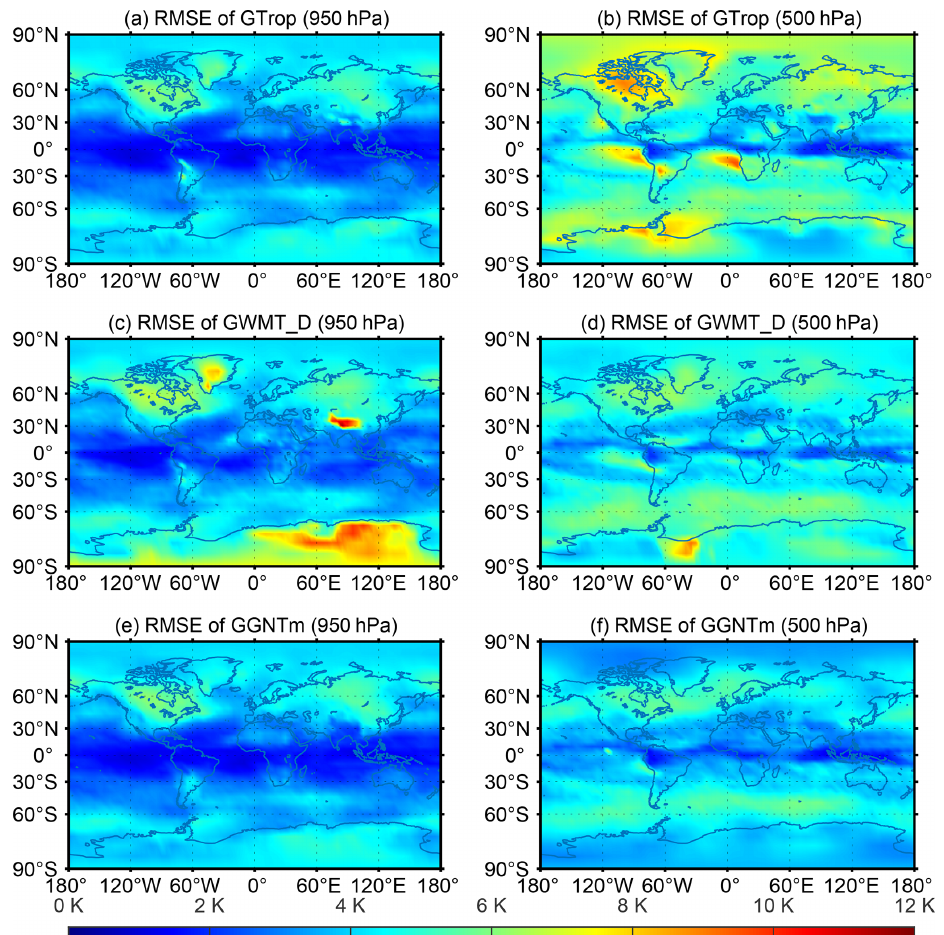
Figure 5. RMSE of T m at each grid point at 950hPa (a, c, e) and 500hPa (b, d, f) pressure levels in 2018 resulting from GTrop, GWMT_D, and